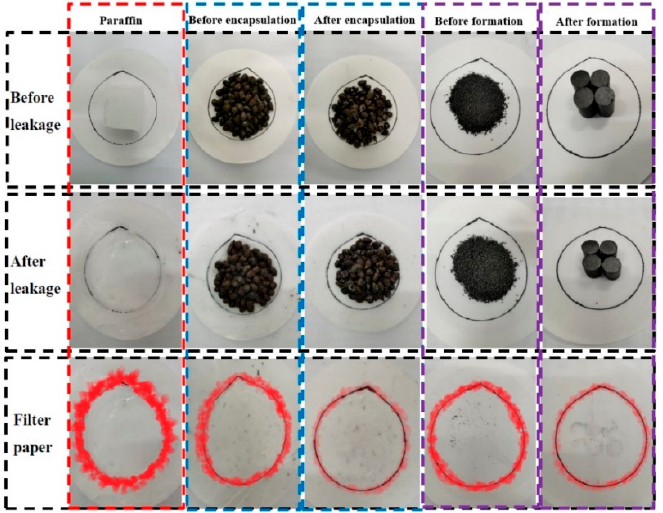
Figure 7. The paraffin leakage region is marked in red for samples before and after heating.